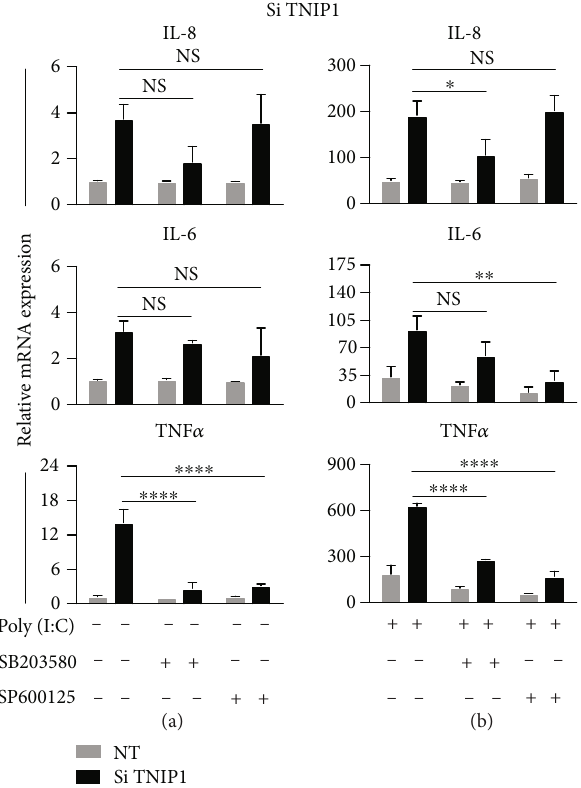
Figure 6: MAPK contributes to increased cytokine gene expression in TNIP1-de fi cient keratinocytes. Gene expression analysis of HaCaT keratinocytes transfected with TNIP1 siRNA (Si) or nontargeting siRNA (NT) after 6hr exposure to (a) vehicle or (b) poly (I:C). Two hours prior to poly (I:C) treatment, cells were treated with either JNK (SP600125, 30 μ M), p38 (SB203580, 10 μ M) inhibitor, or DMSO as vehicle. Data is presented as mean + SEM from two independent experiments with conditions in each set in triplicate. Statistical analysis was performed using two-way ANOVA followed by Bonferroni ’ s post hoc test. Asterisk ( ∗ ) represents statistically signi fi cant di ff erence ( ∗ p value of ≤ 0.05; ∗∗ p value of ≤ 0.005; ∗∗∗∗ p value of ≤ 0.0001. NS: nonsigni fi